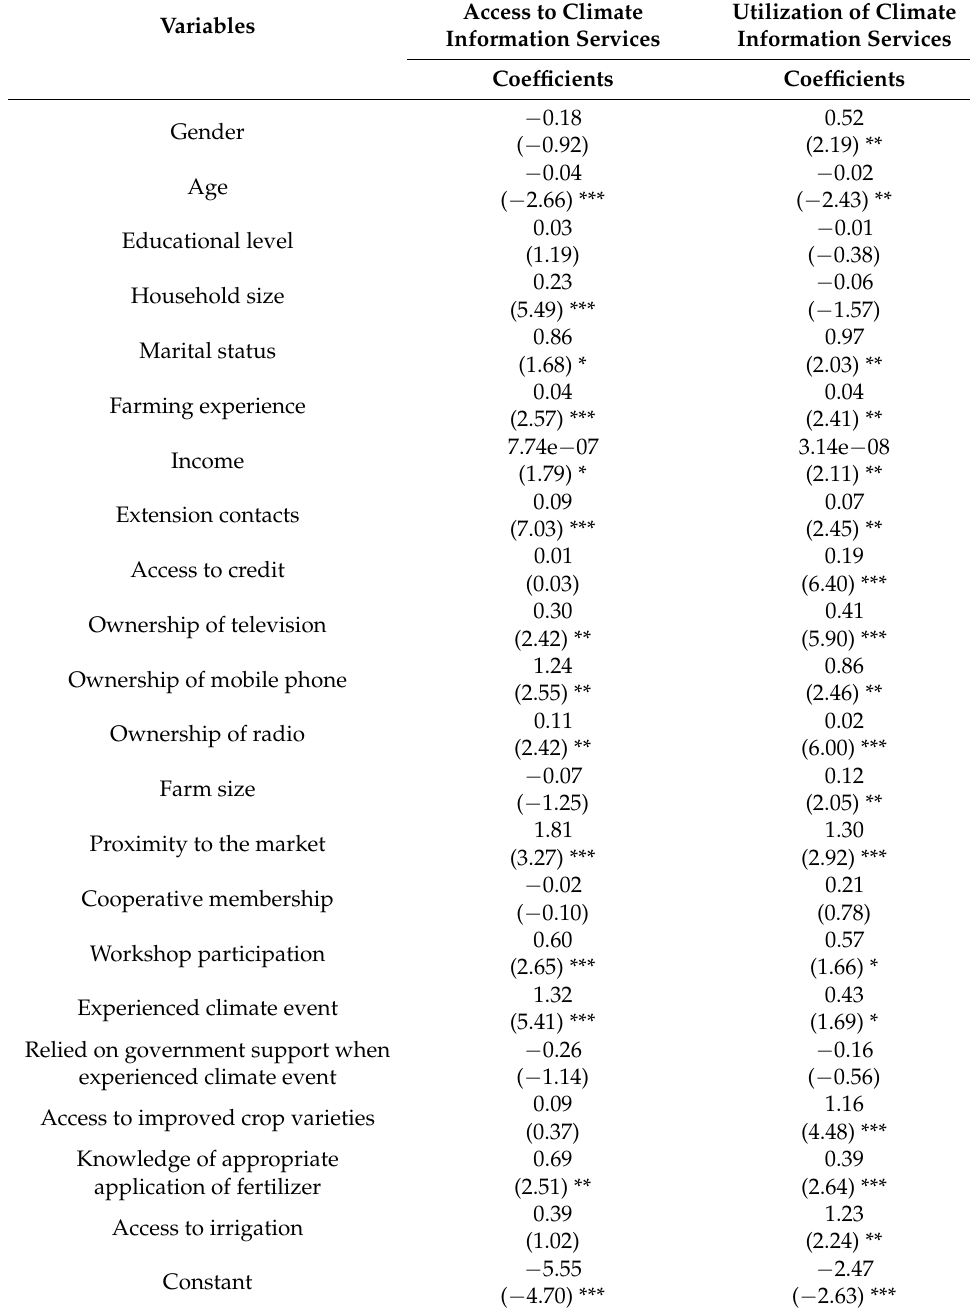
Table 2. Heckman probit selection estimates of the determinants of crop farmers on access and utilization of climate information